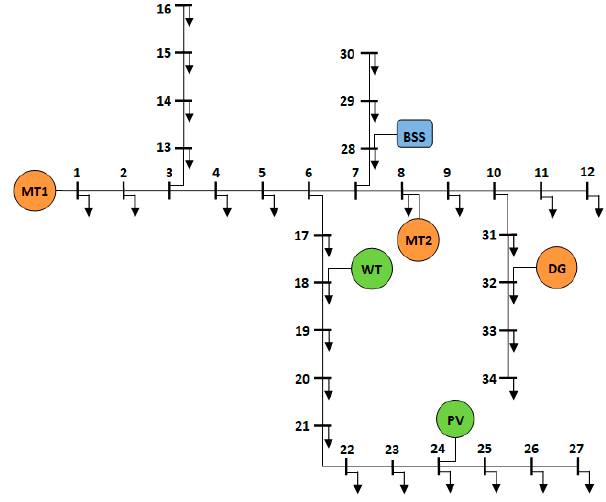
Figure 1. Modified IEEE 34-node test feeder modeled as a Microgrid Network.